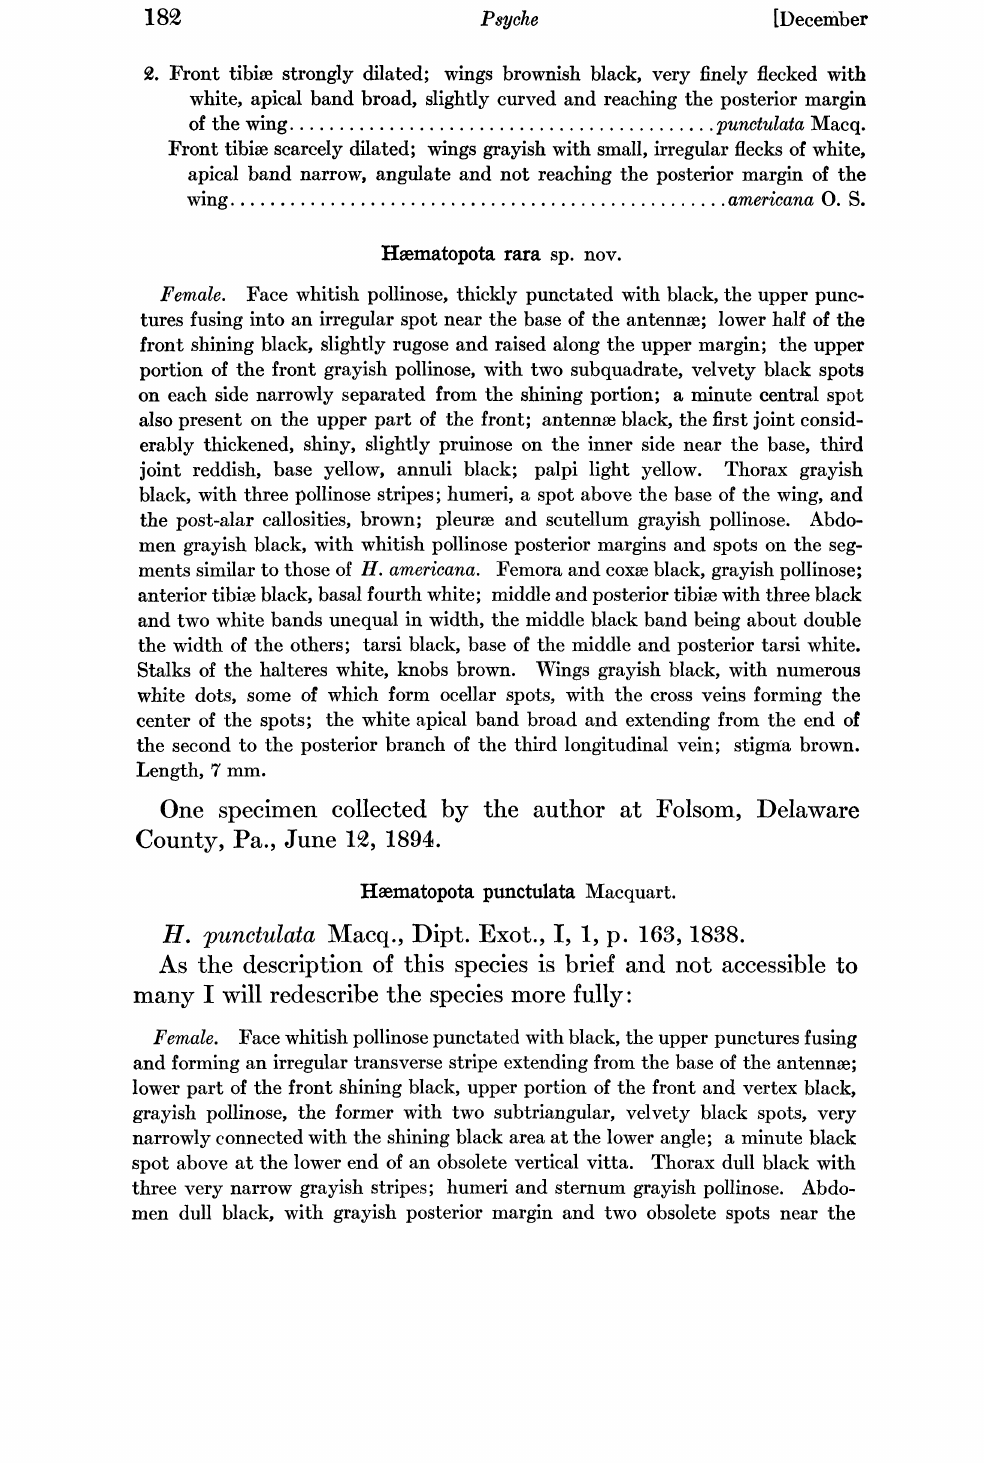
Female. Face whitish pollinose, thickly punctated with black, the upper punc- tures fusing into an irregular spot near the base of the antennm; lower half of the front shining black, slightly rugose and raised along the upper margin; the upper portion of the front grayish pollinose, with two subquadrate, velvety black spots